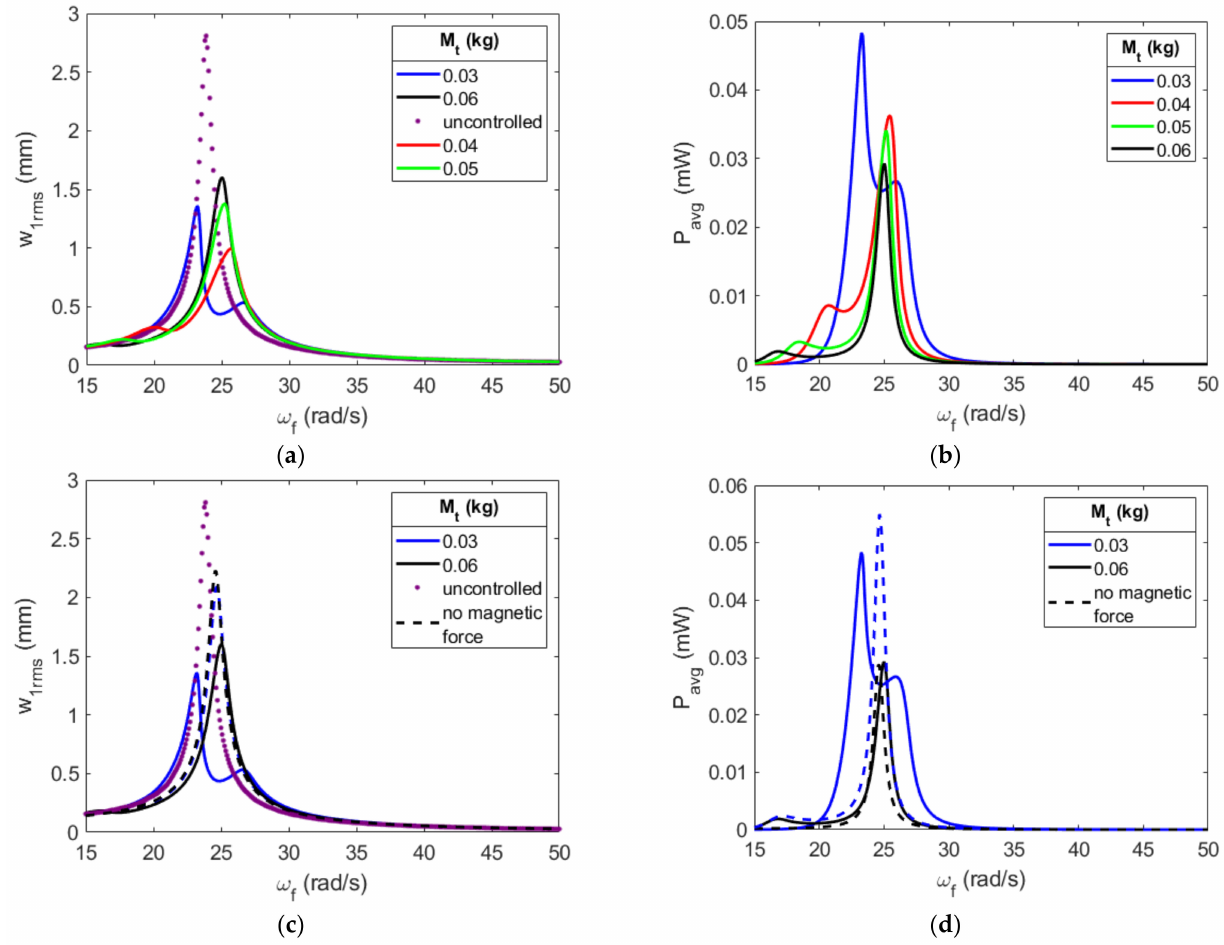
Figure 18. The effects of varying tip masses with a substrate thickness of 0.3 mm and an initial gap of 10 mm on the amplitude of the ( a ) primary structure and ( b ) absorber, as well as a comparison with configurations with no magnets ( c , d